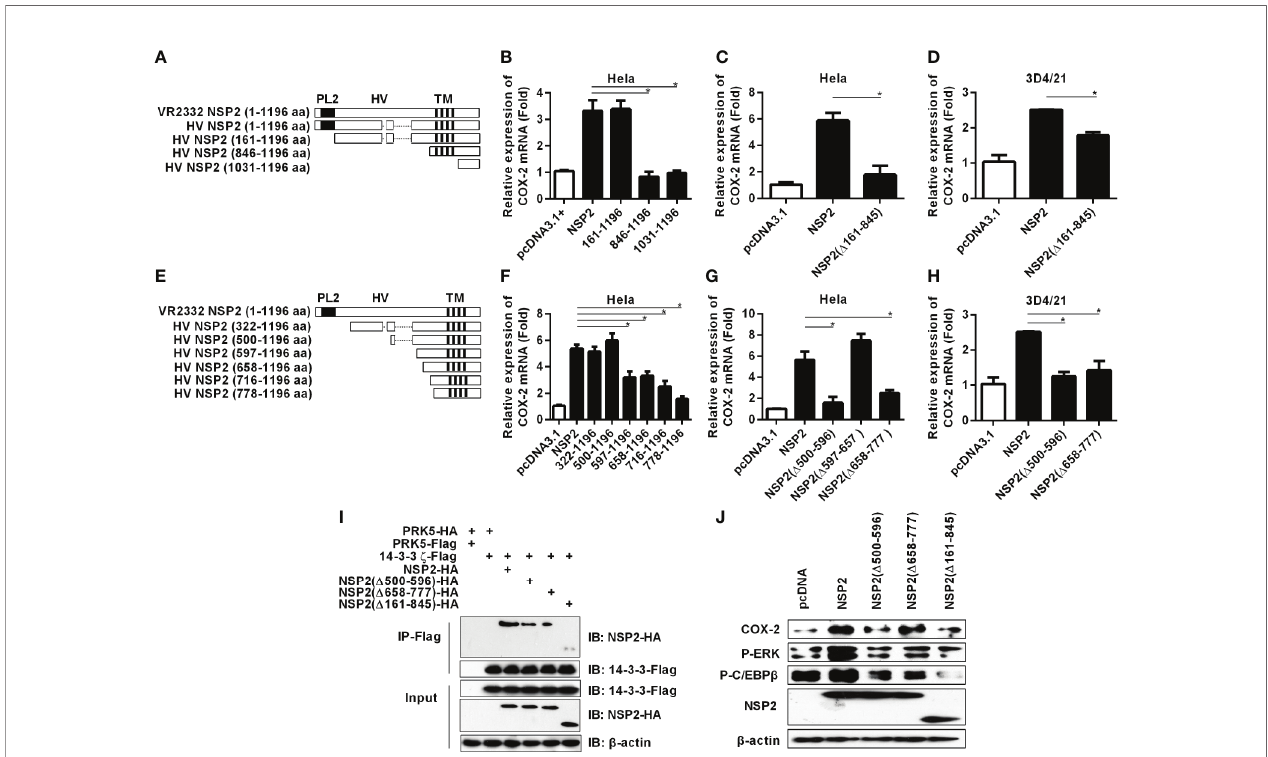
FIGURE 7 | Analysis of functional domain of NSP2 for COX-2 up-regulation. (A) Schematic representation of various truncated mutants of HP-PRRSV strain HV NSP2. The dashed lines indicated the sequence naturally deleted as compared with the North American genotype representative virus VR-2332, including residue 481 and residues 532-560. PL2, the putative enzyme domain; HV, the hypervariable region; TM, the transmembrane region. (B – D) Hela cells (B, C) and 3D4/21 cells (D) were transfected with NSP2, NSP2 deletion mutant vectors, or pcDNA3.1 + empty vector. At 24 hours later, cells were harvested for COX-2 mRNA analysis by real-time PCR. (E) Schematic representation of various truncated mutants of HP-PRRSV strain HV NSP2. The dashed lines indicated the sequence naturally deleted as compared with the North American genotype representative virus VR-2332, including residue 481 and residues 532-560. (F – H) Hela cells (F, G) and 3D4/ 21 cells (H) were transfected with NSP2, NSP2 deletion mutant vectors, or pcDNA3.1 + empty vector. At 24 hours later, cells were harvested for COX-2 mRNA analysis by real-time PCR. (I) HEK-293T cells were co-transfected with Flag-tagged 14-3-3 z and HA-tagged NSP2 deletion mutant expression plasmids. At 24 hours later, cells were harvested for immunoprecipitation. The expression of HA-tagged NSP2 and Flag-tagged 14-3-3 z were analyzed by Western-blot. (J) Hela cells were transfected with NSP2 and NSP2 deletion mutants. At 24 hours later, cells were harvested to detect COX-2, p-ERK, p-C/EBP b , and NSP2 protein levels by Western-blot. Data are representative of three independent experiments (mean ± SEM). Statistical analysis was performed by Student ’ s t -test. *, P < 0.05